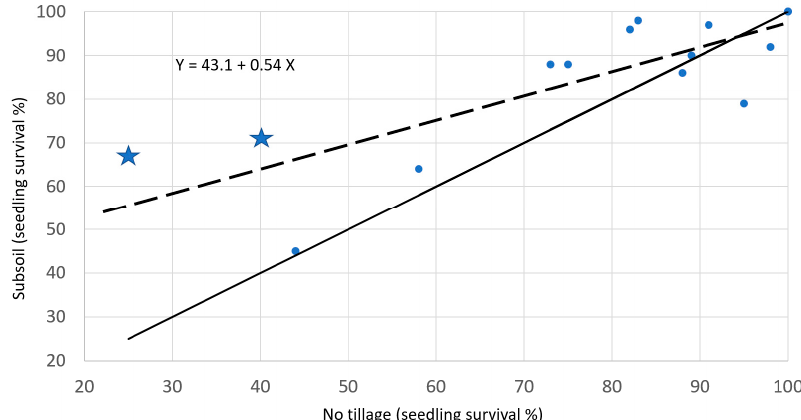
Figure 6. Subsoiling increased the survival of loblolly pine seedlings ( n = 15) by an average of 8 percent [2], and the increase was 13% on sites with less than 90% survival ( n = 10). Sites with less than 50% survival were planted in early 1995, a year with below-average rainfall. At two sites in Saluda County, South Carolina (Stars), March to May (1995), rainfall was 160 mm below normal. Points above the solid line represent sites where subsoiling increased survival. p > |t| = 0.001 for intercept and 0.0025 for slope; R 2 =